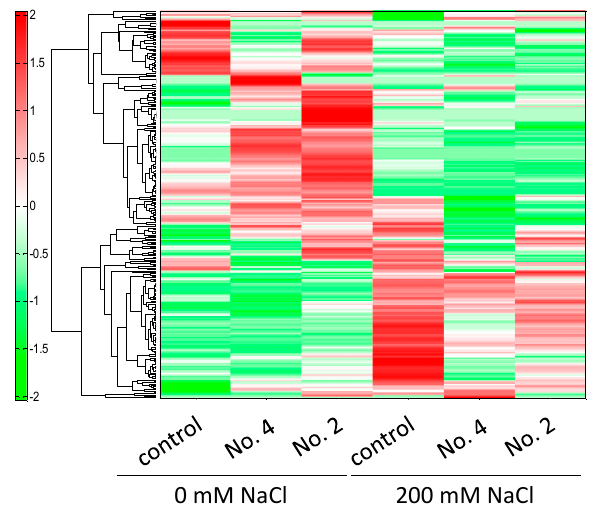
Figure 5. Heatmap of all metabolites based on relative peak area in mock-inoculated ice plants and those inoculated with strain 4 and strain 2. Horizontal axis and vertical axis show sample names and peaks, respectively. Distances between peaks are displayed in the tree diagram. Green (low) to red (high) represent the increase in relative area of each peak among the three treatments. Data in this figure correspond to Table S1.